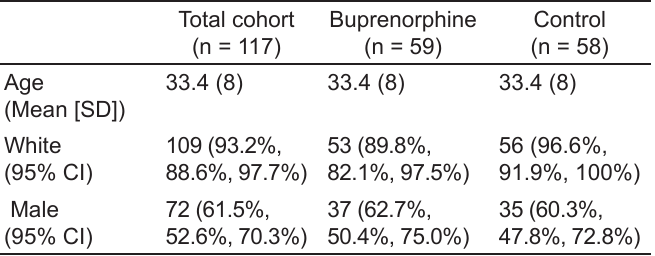
Table 1. Demographics of the study cohort.